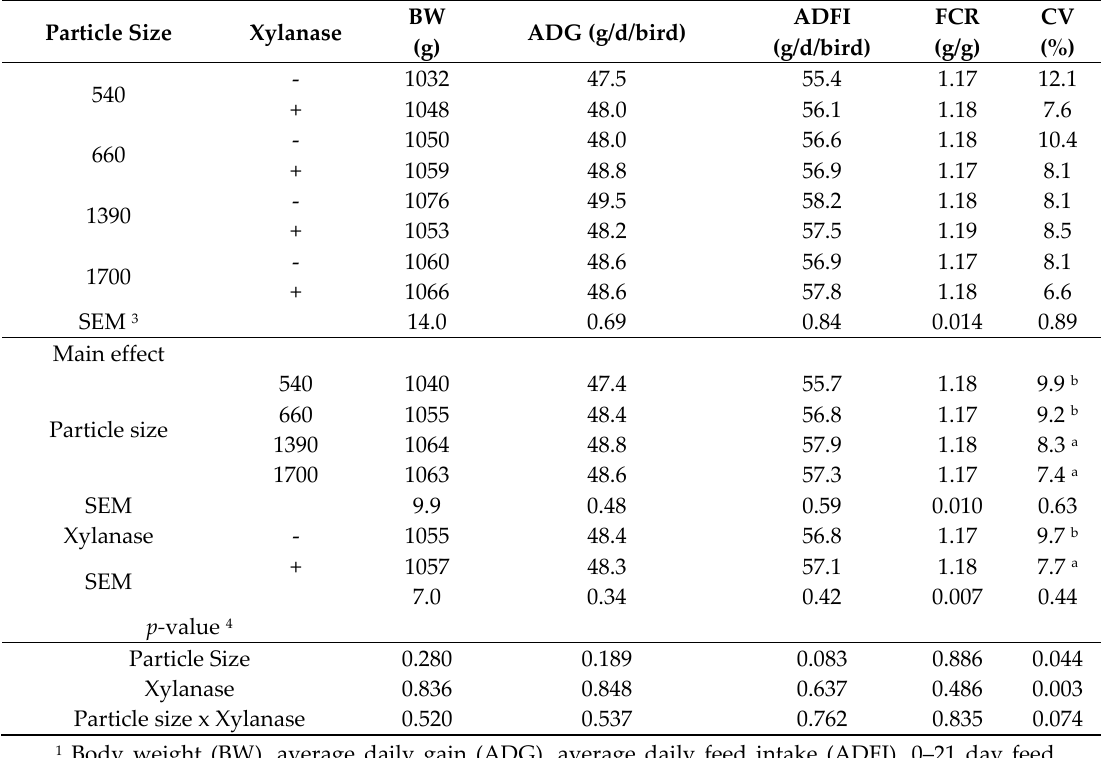
Table 5. Effects on performance 1 of particle size and xylanase inclusion 2